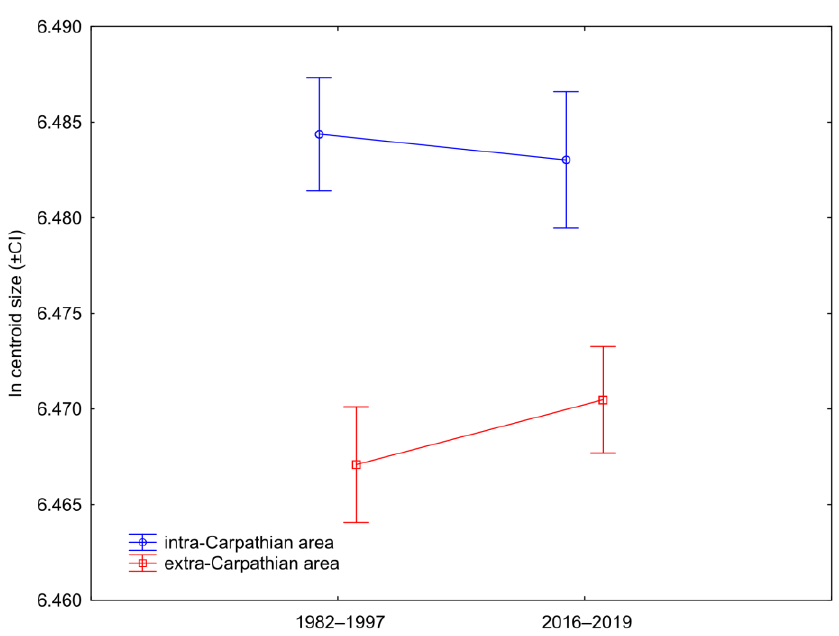
Figure 5. Differences in wing size ( ± 95% confidence intervals) between the intra- and extra- Carpathian samples collected in the years 1982–1997 and 2016–2019.